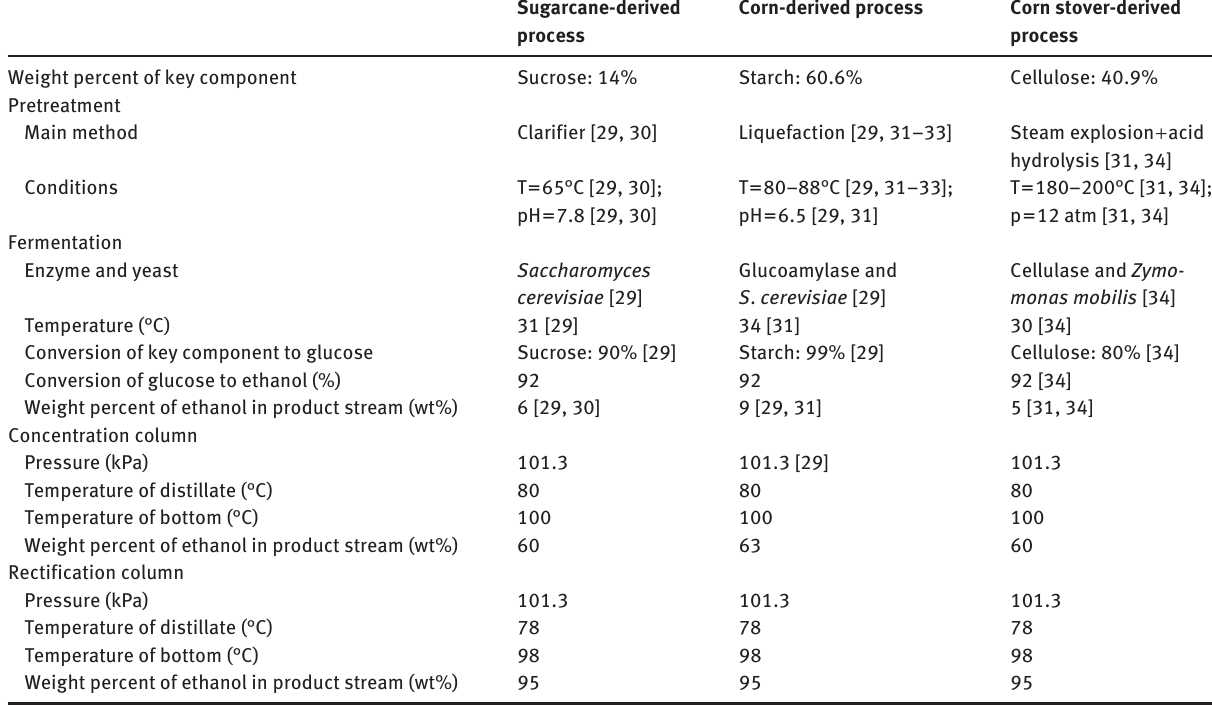
Table 1 Conditions of the main process units included in bioethanol production processes. The conversion of glucose to ethanol in the corn stover-derived process was obtained by Wooley et al. [34] and is assumed to be the same in all processes. The pressure condition of the concentration and the rectification column was obtained by Quintero et al. [29] and is assumed to be the same in all processes. The temperatures of distillate and bottom streams and the weight percent of ethanol in the product stream of the concentration and the rectification columns are obtained by simulation under the considered